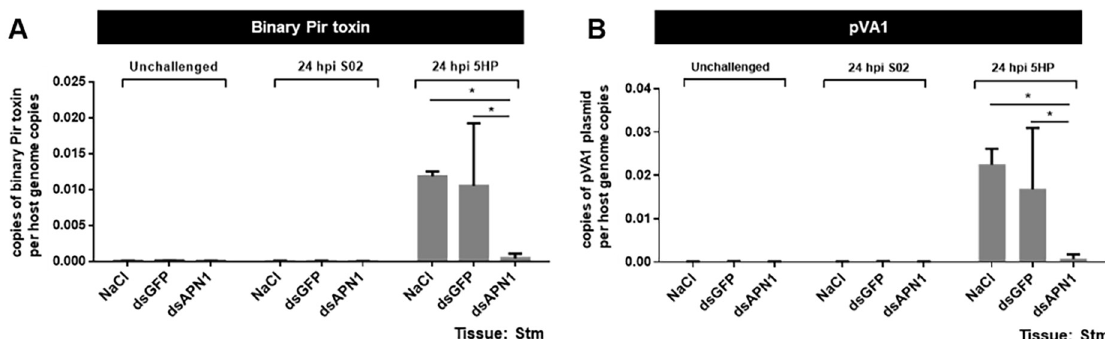
Fig 5. Reducing of AHPND-causing bacteria plasmid in stomach of Lv APN1 silenced shrimp. PCR amplification of two different sequences in the genome of the pVA1 plasmid, (A) Binary Pir toxin sequence and (B) pVA1 sequence from the stomach of shrimp injected with 0.85% NaCl, 20 μ g/g shrimp of dsGFP, or 20 μ g/g shrimp of dsAPN1. Shrimp stomach were collected after dsRNA injection (unchallenged) and after infection with the AHPND-causing V . parahaemolyticus 5HP strain and non-AHPND causing V . parahaemolyticus S02 at 24 h. The data represent copies of pVA1 plasmid per host genome copies. Each bar represents the mean ± standard deviation (SD) of triplicate experiments. Asterisks indicate significant difference ( P < 0.05).